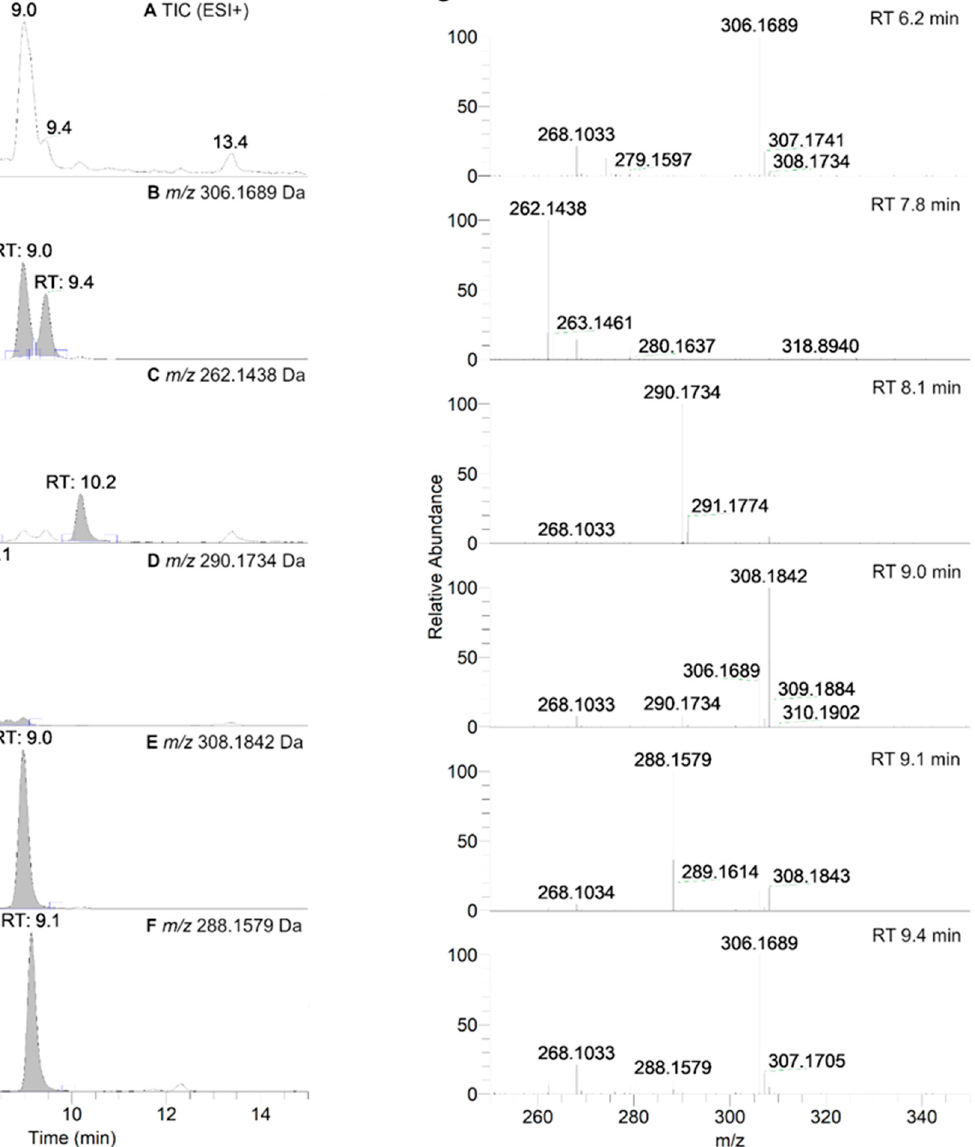
Figure 7. HPLC-HRMS study of nitroxide 5 (300 µ M) incubated with RLM (7.8 mg · mL − 1 protein, 30 µ M P450) supplemented with NADPH (2 mM) in potassium phosphate buffer (100 mM; pH 7.4) upon aerobic conditions after 60 min. ( Panel A ) shows the TIC chromatogram in ESI + . ( Panels B – F ) display reconstructed chromatograms of the principal ions in ESI + mode identified at m / z = 306.1689, 262.1438, 290.1734, 308.1842, and 288.1579 Da, respectively. ( Panel G ) represents the HRMS spectra of the peaks at retention times (RT) = 6.2, 7.8, 8.1, 9.0, 9.1 and 9.4 min. Peaks in TIC chromatograms were observed with a delay of 0.2 min compared to the UV-Vis detection.